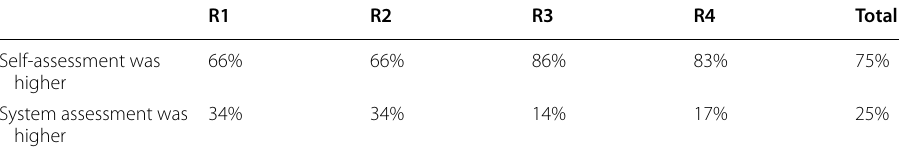
Table 5 Comparison of initial self-assessment and initial system